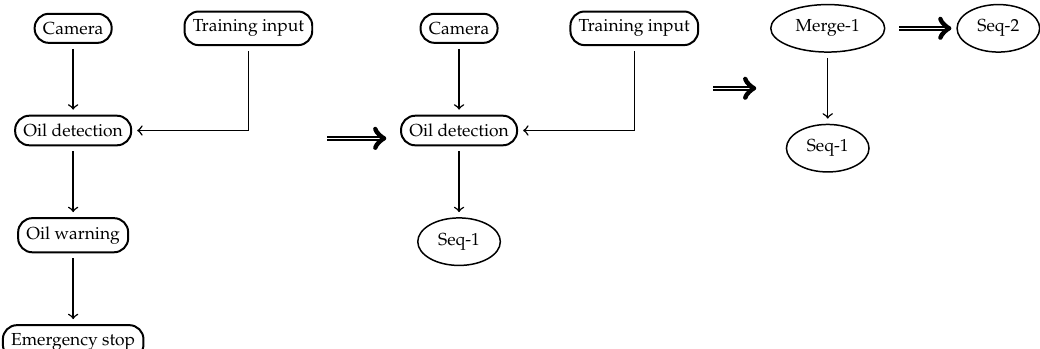
Figure 6. Translation steps from application graph into pattern